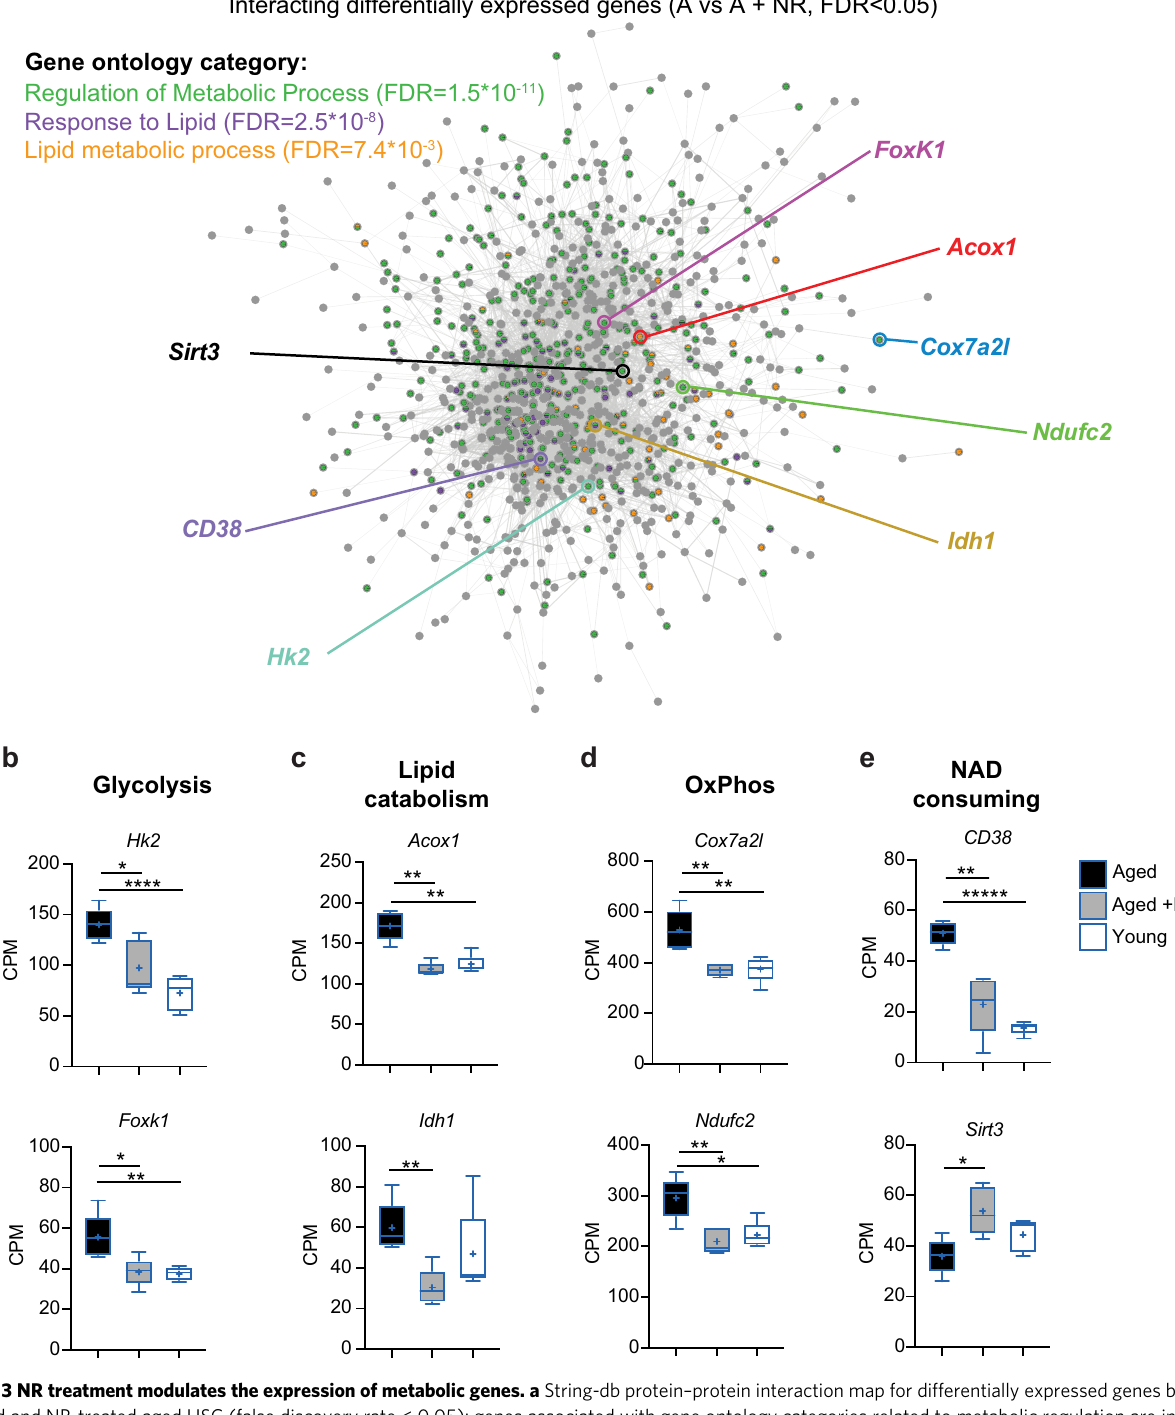
Fig. 3 NR treatment modulates the expression of metabolic genes. a String-db protein – protein interaction map for differentially expressed genes between aged and NR-treated aged HSC (false discovery rate < 0.05); genes associated with gene ontology categories related to metabolic regulation are indicated by coloured nodes. b – e Expression levels of key genes associated with glycolysis, lipid catabolism, oxidative phosphorylation and NAD consumption in aged HSC ( n = 5, biological replicates), NR-treated aged ( n = 5, biological replicates) and young HSC ( n = 5, biological replicates). Statistical analysis was performed using String-db ( a ) and EdgeR (false discovery rates between two groups were determined considering the third group as background, b – e ). Data are expressed as box-and-whisker plots. Box indicates 25th to 75th percentile, line indicates the median and whiskers indicate min to max values. *FDR < 0.05, **FDR < 0.01, ***FDR < 0.001, ****FDR < 0.0001, *****FDR < 0.00001. Only statistically signi fi cant comparisons are indicated. Exact FDR values comparing individual groups associated with b – e are presented in Supplementary Fig. 3d. NR nicotinamide riboside, HSC hematopoietic stem cells, OxPhos oxidative phosphorylation, CPM TMM-corrected counts per million sequencing reads, Y young, A aged, A + NR NR-treated aged animal. Source data are provided as a Source Data